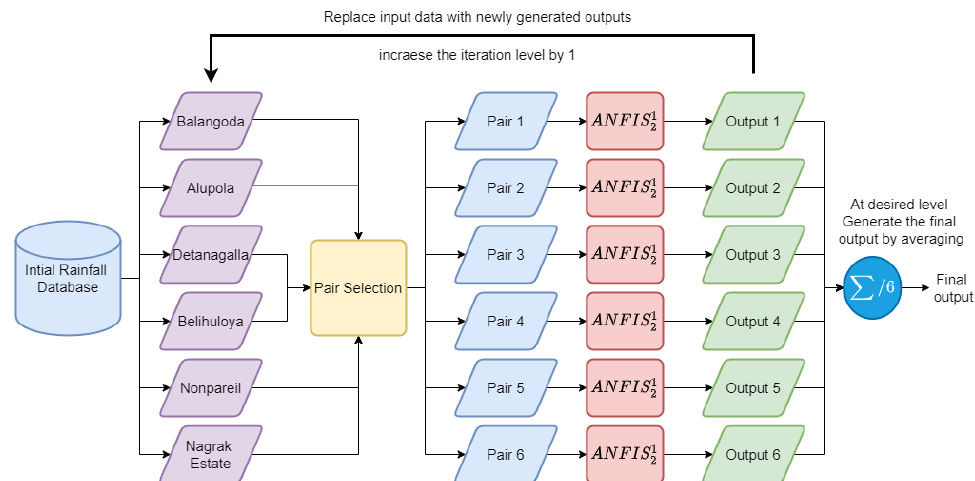
Figure 3. Hydropower prediction Cascaded ANFIS